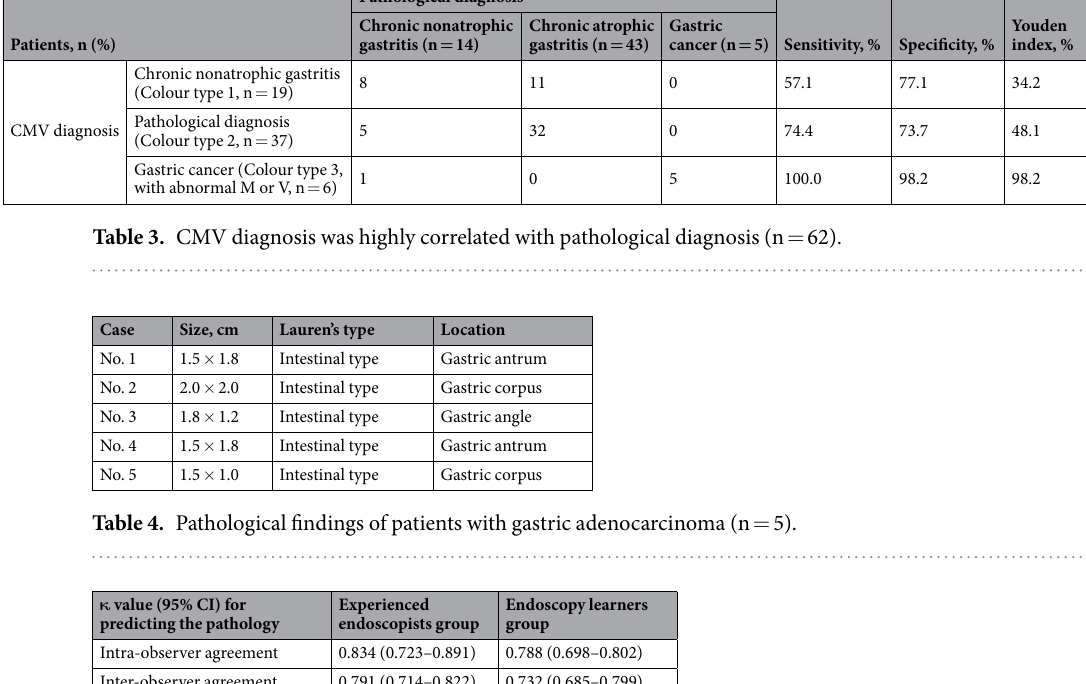
Table 5. Intra-observer and inter-observer